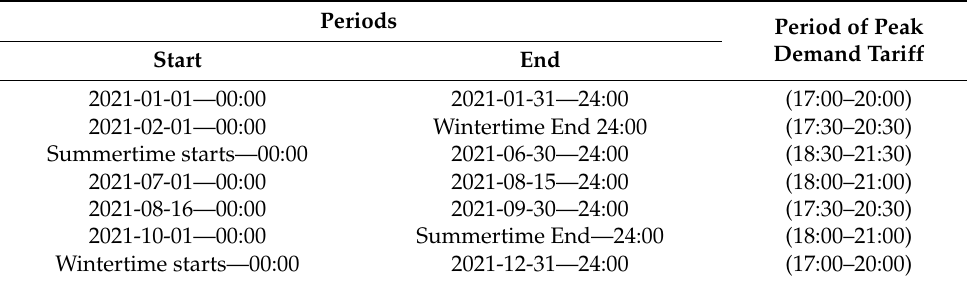
Table 4. Peak tariff periods for